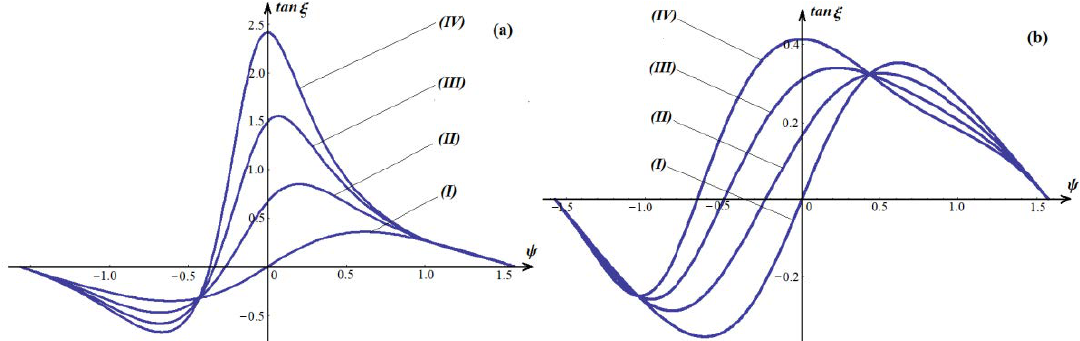
k depending on the ray angle  : ( a ) ( I )—( Figure 7. Directions of ship waves / ( ) Y X Figure 7. Directions of ship waves Figure 7. Directions of ship waves − k Y / k X = tg ( ψ ) depending on the ray angle ξ : ( a ) ( I )—( W X = W Y = 0), ( II )— √ ( W X = W Y = 0.4), ( III )—( W X = W Y = 0.6), ( IV )—( W X = W Y = 1/ 2); ( b ) ( I )—( W X = W Y = 0), ( II )—( W X = − W Y = − 0.2), √ ( III )—( W X = − W Y = − 0.45), ( IV )—( W X = − W Y = − 1/ 2).